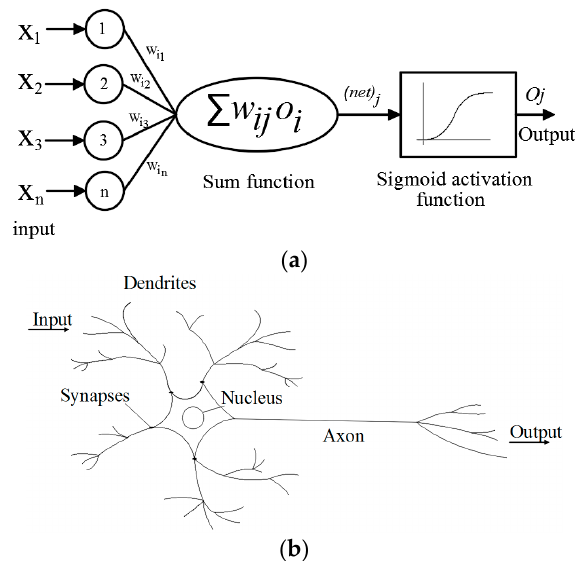
Figure 1. Schematic illustration of ( a ) artificial neuron; and ( b ) biological neuron.